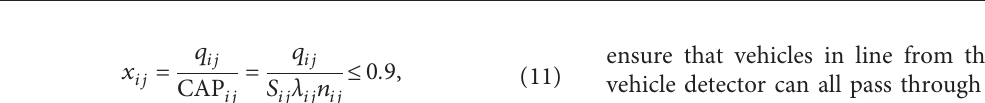
Figure 3: Delay analysis of different lane combination schemes. Table 2: Criteria of the congestion degree of the entrance lanes at intersections. Degree of congestion in steering lane Very high